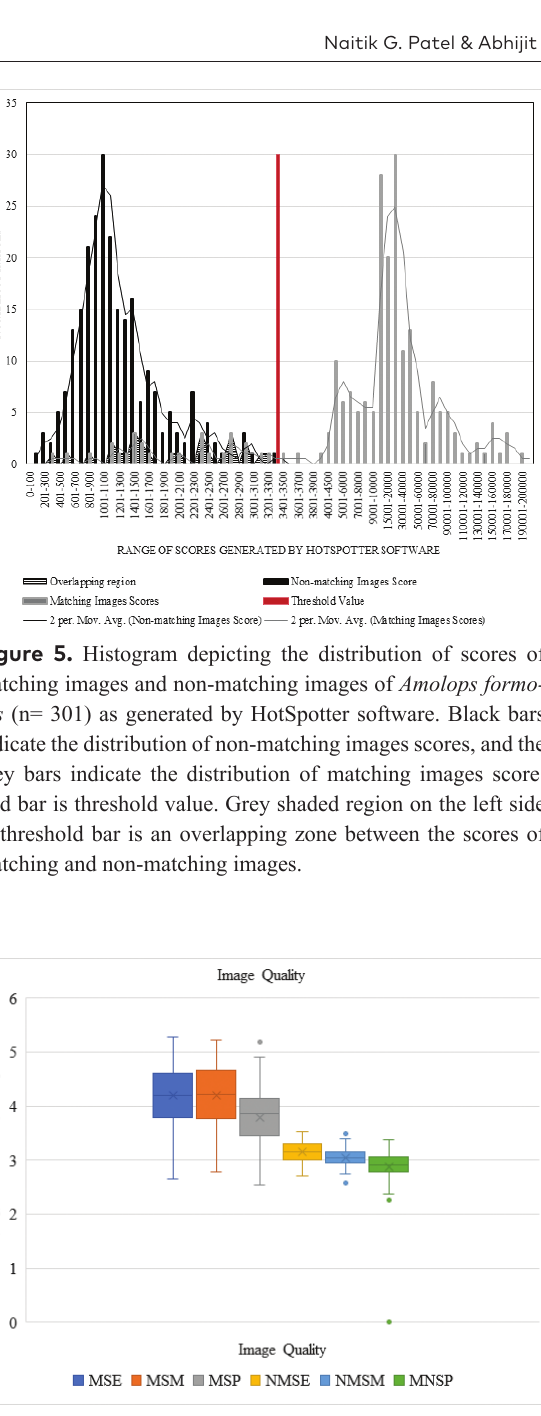
Figure 6. Distribution of scores (log) generated by HotSpot- ter. The scores of MSE (Matching Score Excellent), MSM (Matching Score Moderate), and MSP (Matching Score Poor) are higher compared to NMSE (Non-Matching Score Excel - lent), NMSM (Non-Matching Score Moderate), and NMSP (Non-Matching Score Poor).